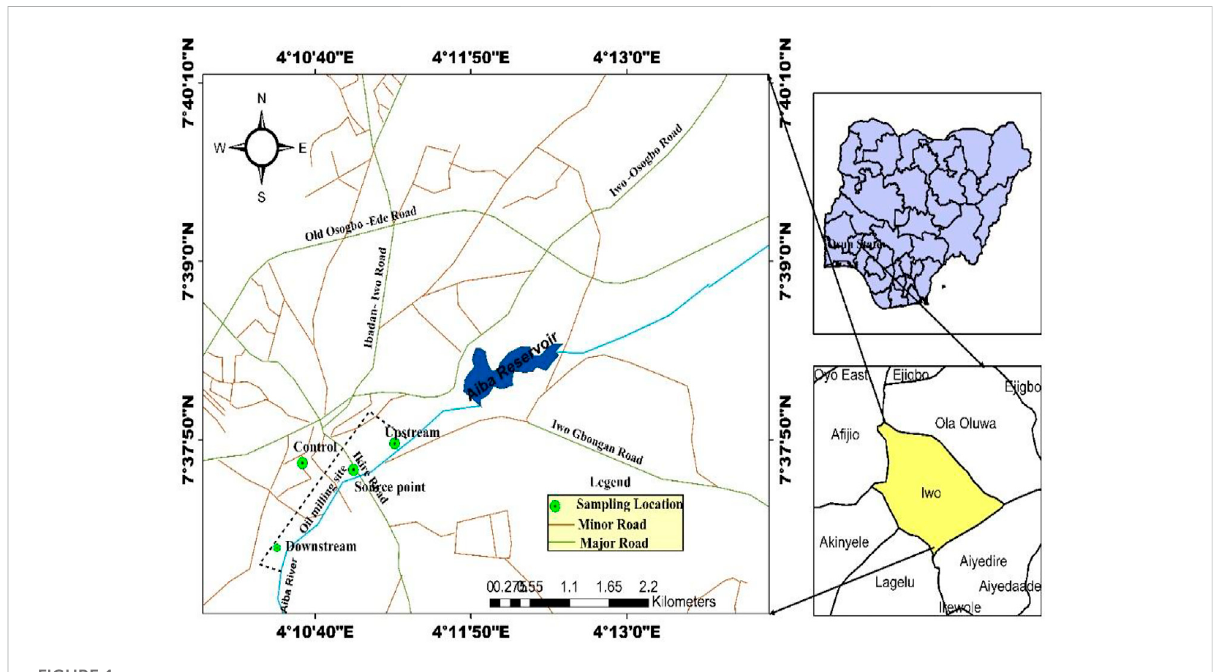
FIGURE 1 Map showing the study site in Iwo, Osun State,